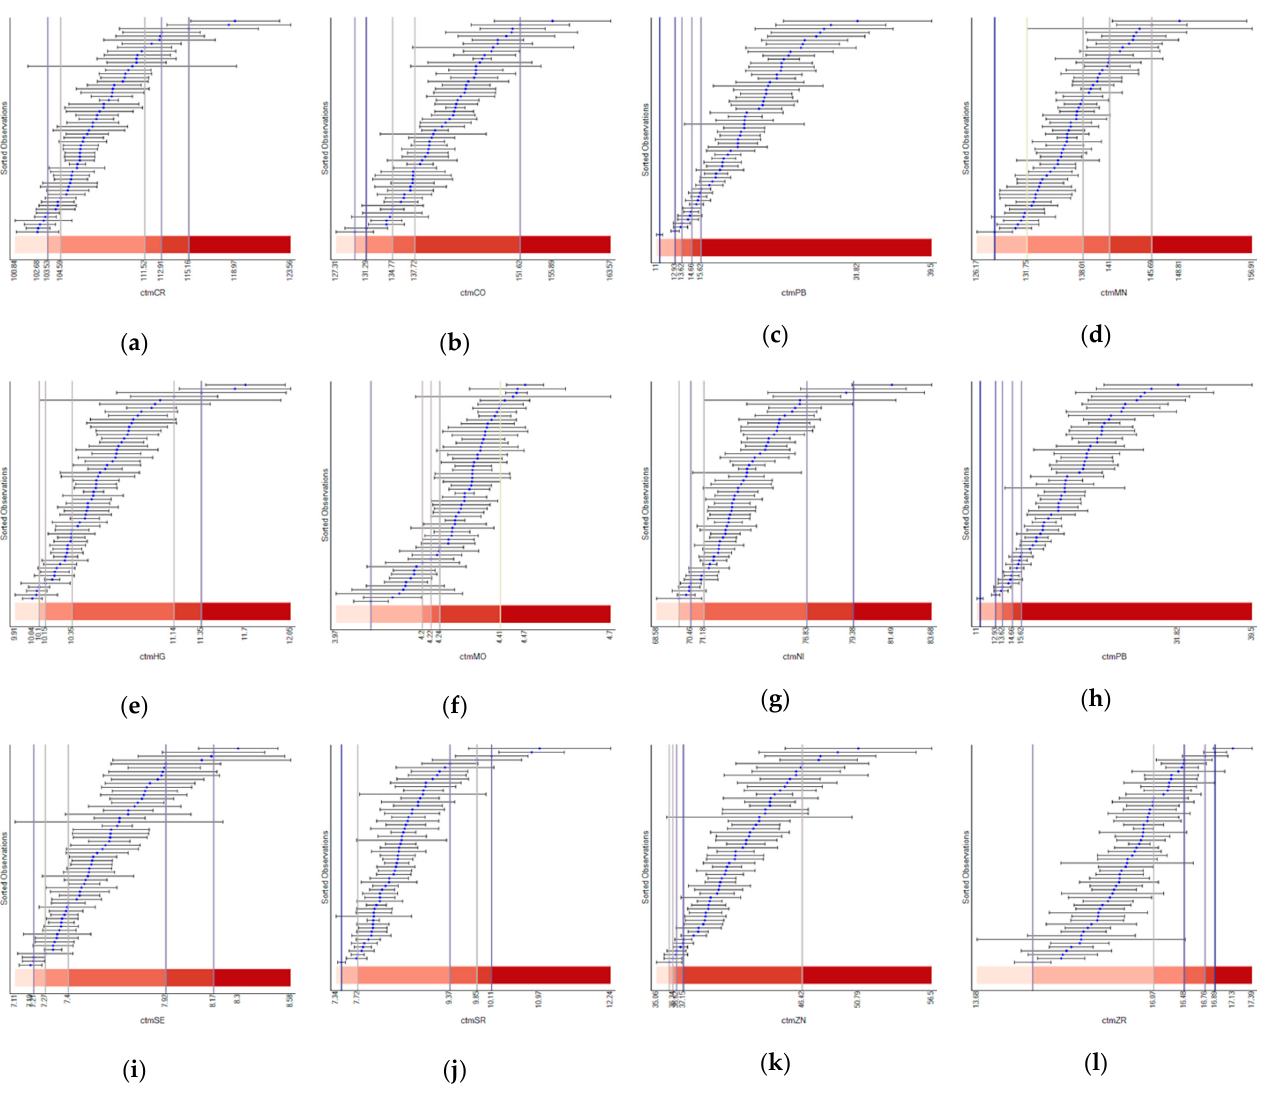
Figure A3. Classification results of assay errors and the corresponding resampling error for three selected heavy metals: